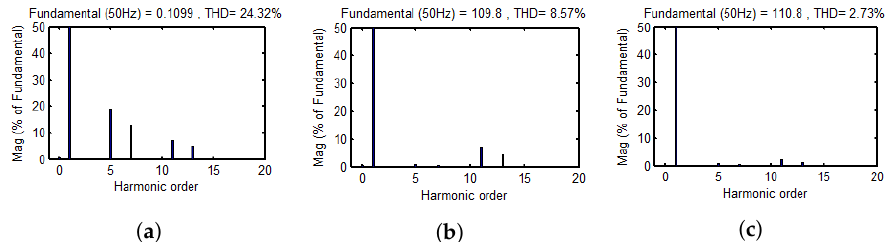
Figure 9. Current waveform spectra for grid-side winding from the left column under three working conditions. ( a ) Working condition 1. ( b ) Working condition 2. ( c ) Working condition